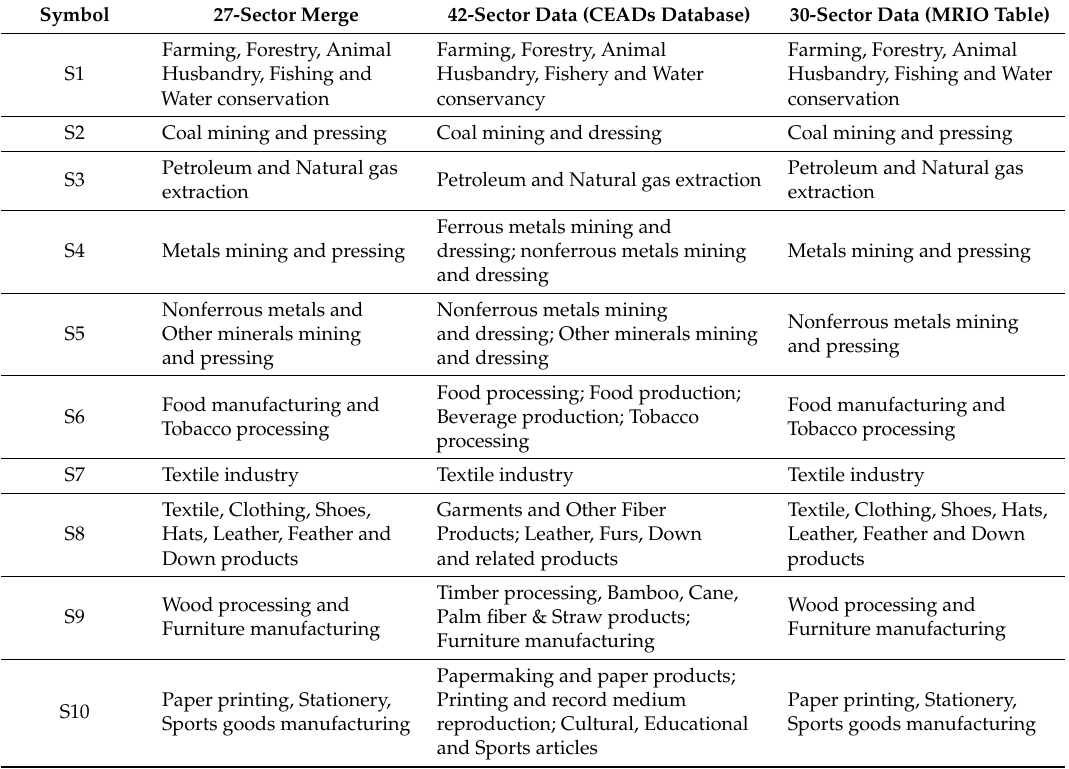
Table 2. Details of merged